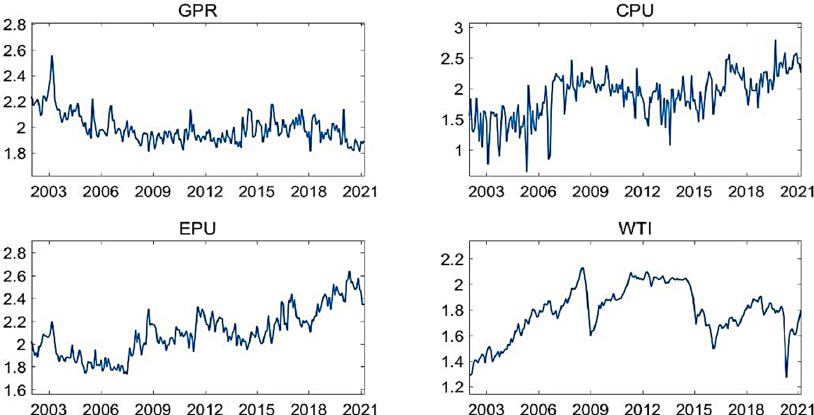
Figure 1. Three uncertainties and crude oil price trends.